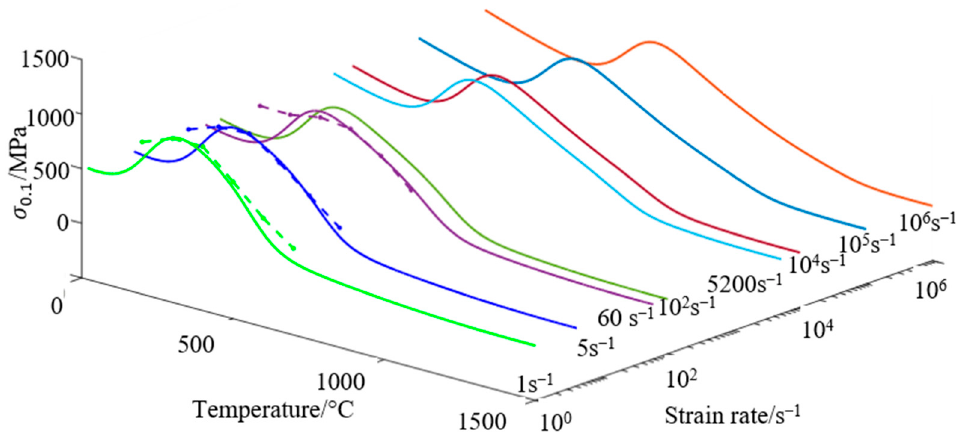
Figure 2. Initial yield stress ( σ 0.1 ) for varying temperature and strain rate with the modified Johnson–Cook (JC) model extrapolated to high strain rates to accommodate machining conditions (Experimental data is plotted with dashed lines and model-predicted data is plotted with continuous lines).